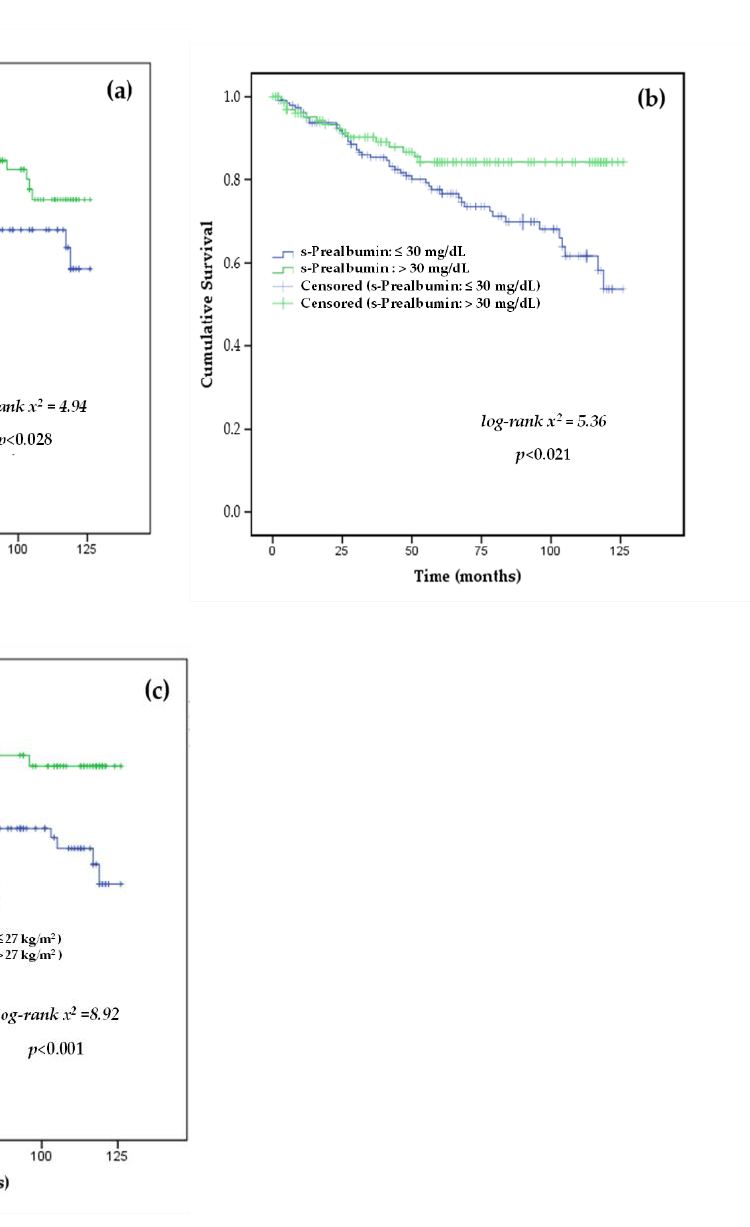
Figure 3. Kaplan–Meier survival curves of the study participants stratified by the cut-off-points of ( a ) phase angle (PA: ≤ 4 vs. >4 ◦ ), ( b ) s-Prealbumin ( ≤ 30 vs. >30 mg/dL), and ( c ) handgrip strength in males (HGS: ≤ 26 vs. >26 kg/m 2 ) and in females (HGS: ≤ 17 vs. >17 kg/m 2 ) as mortality risk predictors in stage 3b, 4–5 chronic kidney disease